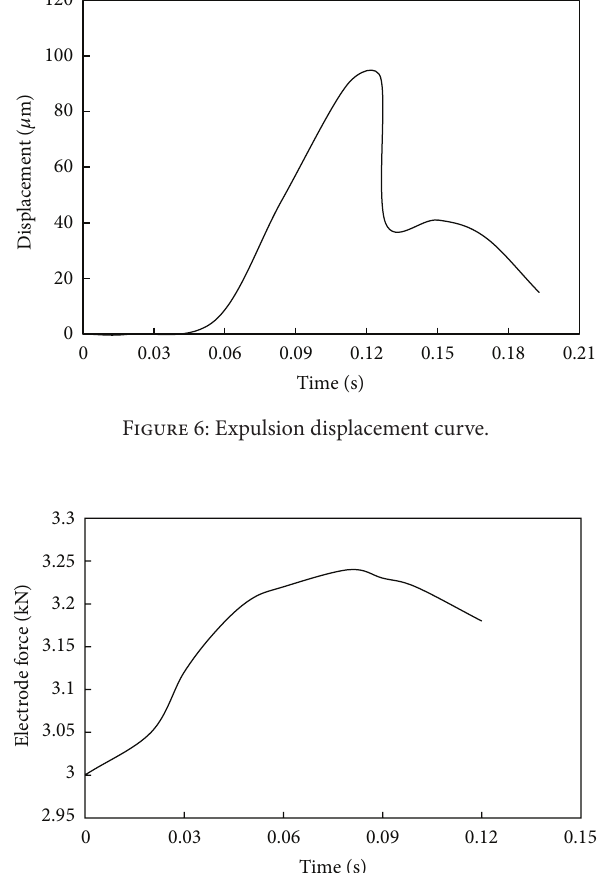
Figure 7: Typical electrode force curve when welding stainless steel.